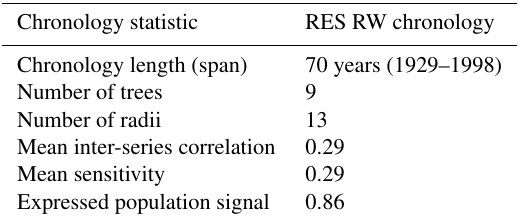
Table 2. Statistics of RES ring-width chronology for P. lawrencei